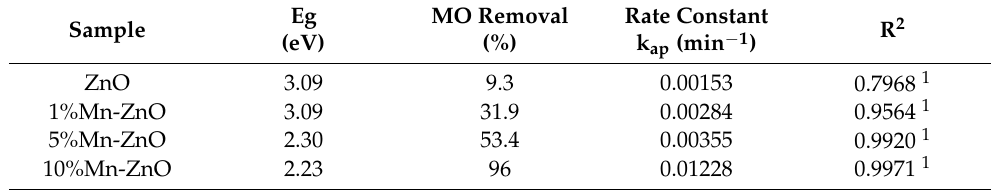
Table 1. Band gap energies and MO conversion under visible light irradiation in the presence of ZnO and x%Mn-ZnO nanomaterials.